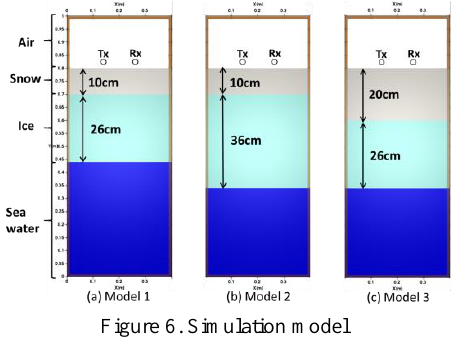
Figure 6. Simulation model